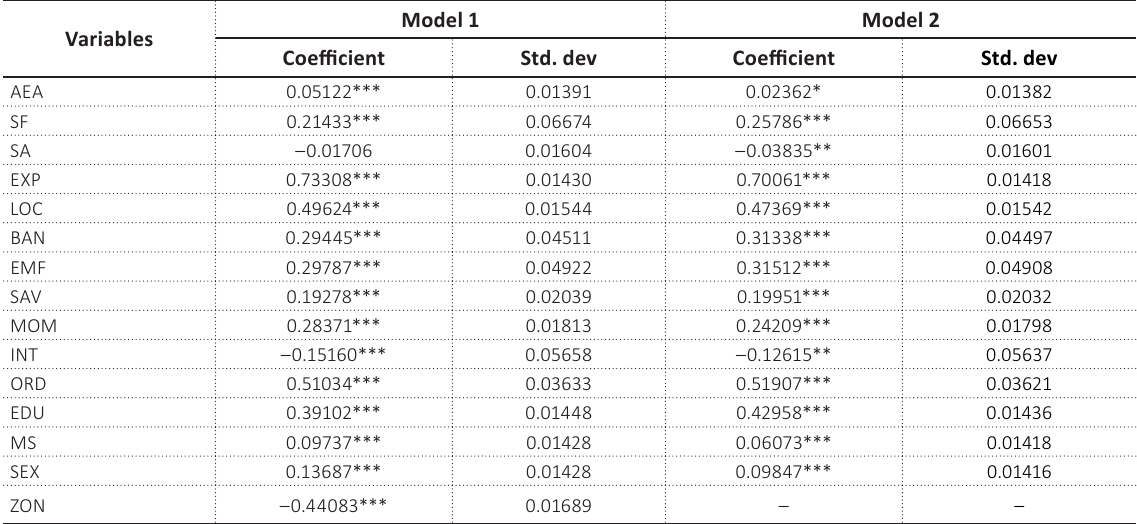
Table 3. Estimates of simple logit of the determinants of access to renewable